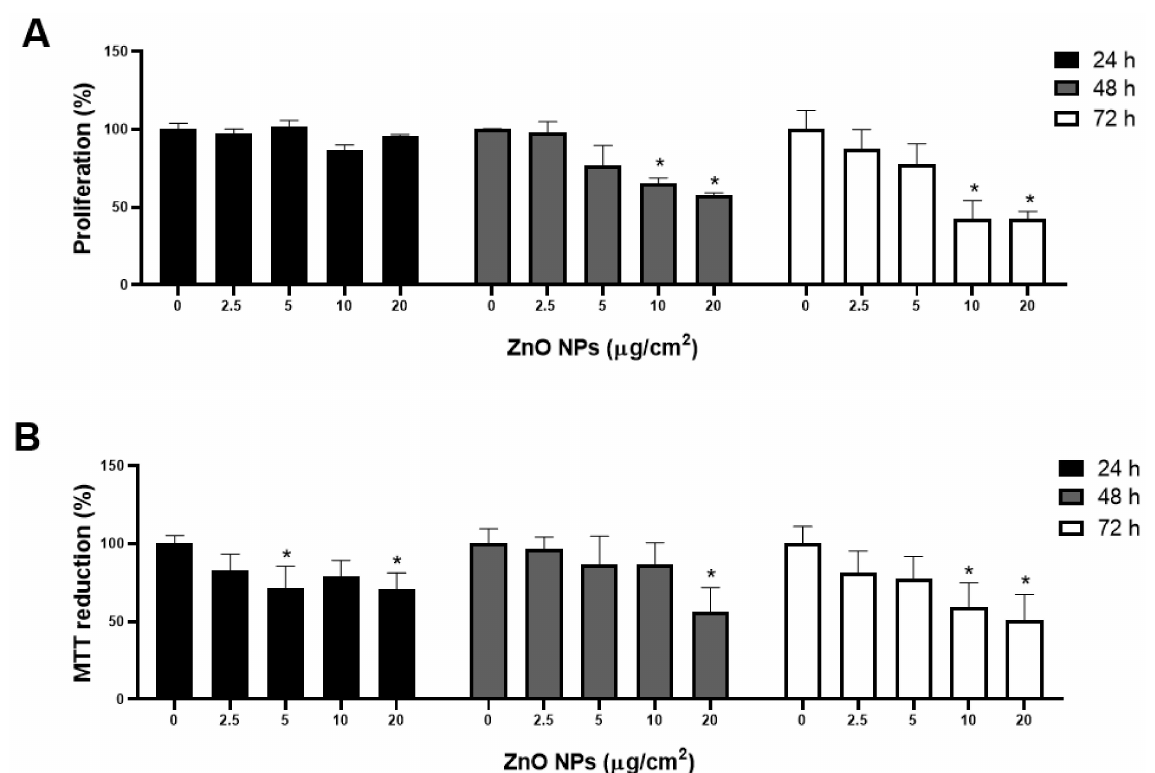
Figure 5. ZnO NP effects on cell proliferation and viability. Cells (3 × 10 3 /well) were exposed to 0, 2.5, 5, 10, and 20 µ g/cm 2 of ZnO NPs for 24, 48, and 72 h. Cell proliferation and viability were measured by crystal violet staining ( A ) and MTT reduction ( B ), respectively. Results were expressed as mean ± standard deviation of three independent experiments. * p < 0.05 compared with